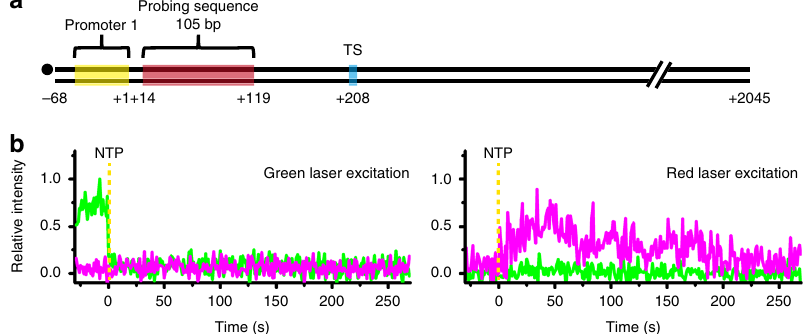
Fig. 6 Upstream reinitiation occurring on the original promoter. a A DNA template has the probing target sequence (brown box) within a transcription unit located in an upstream part. b A representative type-1 fl uorescence trace pattern, indicating reinitiation events is